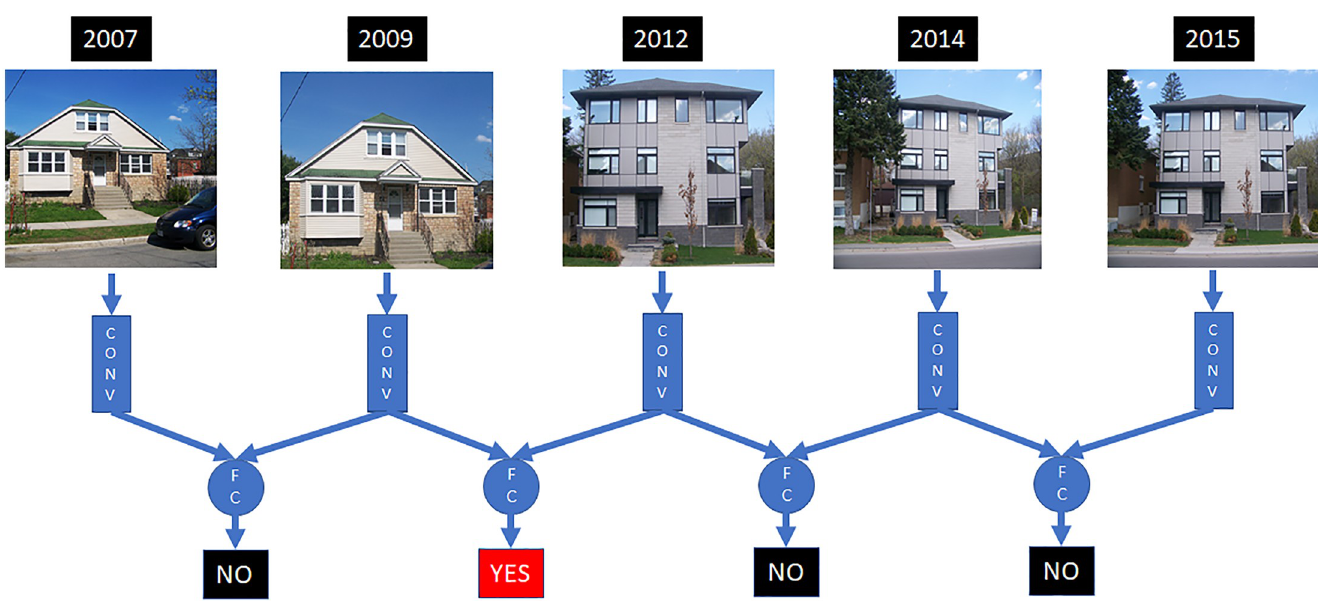
Fig 4. Example of detecting gentrification-like change within a sequence of GSV images at the same geographic location using SCNN-FC-8. In this example, the GSV image from 2007 and 2009 are input into the SCNN-FC-8 and the model detects whether there is a gentrification-like visual change. Only the images between 2009 and 2012 are detected as exhibiting a gentrification-like visual change in the sequence of GSV images. Each detection is recorded along with the geographic coordinates (s x,y ) of the sequence for subsequent mapping. In order to comply with CC-BY copyright, these photos are the author’s and are not GSV imagery and so are provided for illustrative purposes only. Figure with the GSV sequence for this example can be found here: https://github.com/laggiss/DeepMapping/blob/master/